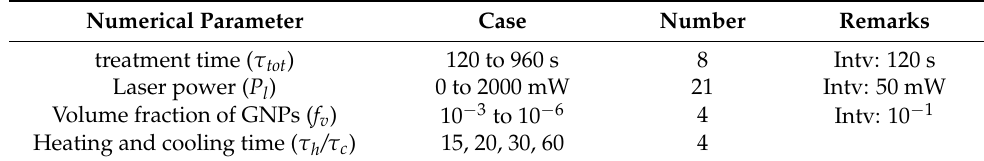
Table 5. Geometry of simulation conditions.